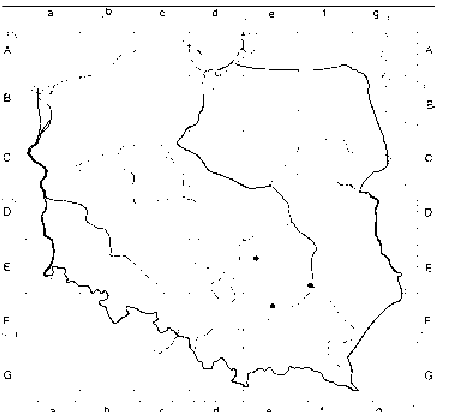
Fig. 2. Distribution of Polyporus rhizophilus in